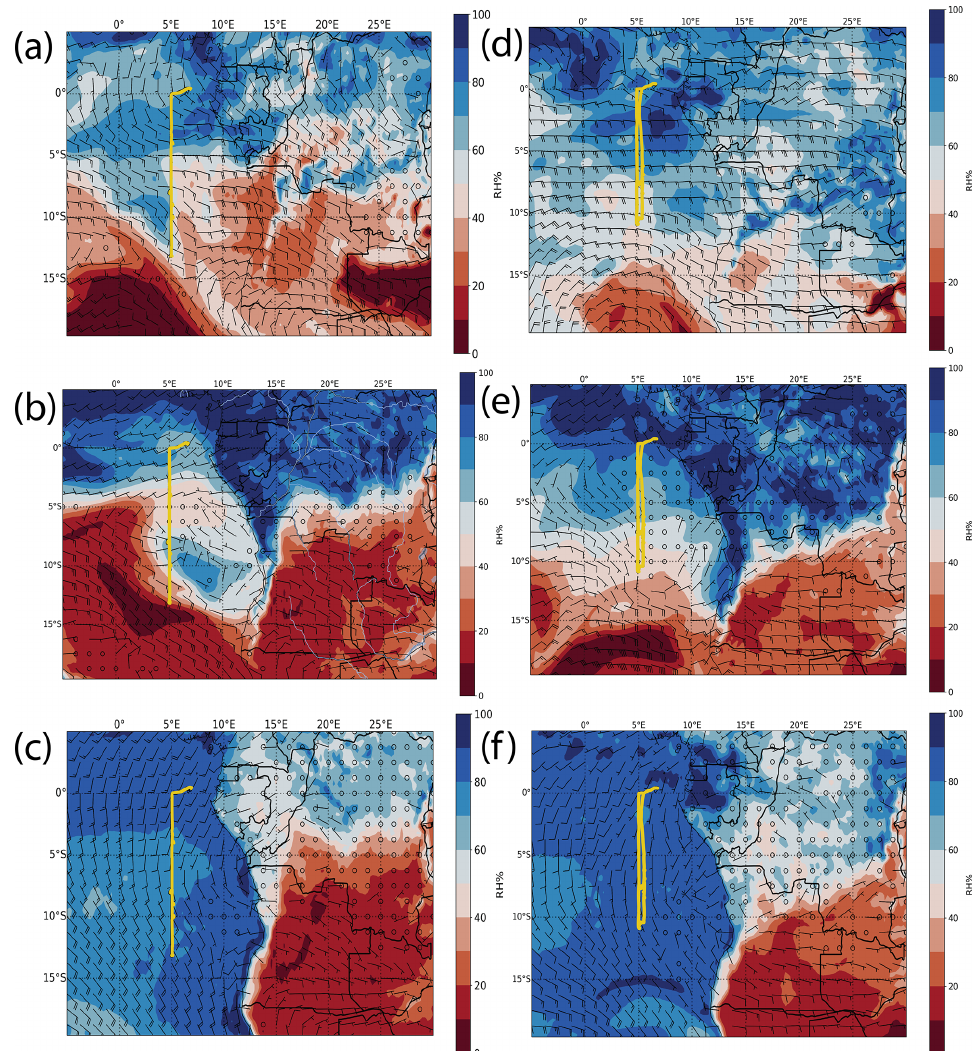
Figure 1. European Centre for Medium-Range Weather Forecasts 0h reanalysis at 12:00UTC on 30 August 2017 (a–c) and 2 Octo- ber 2018 (d–f) . (a, d) The 700hPa relative humidity, along with wind. (b, e) The 850hPa relative humidity and wind. (c, f) Surface relative humidity and wind. Wind barbs are as follows: small barbs are 5ms − 1 , and large barbs are 10ms − 1 . The flight track is shown as a yellow